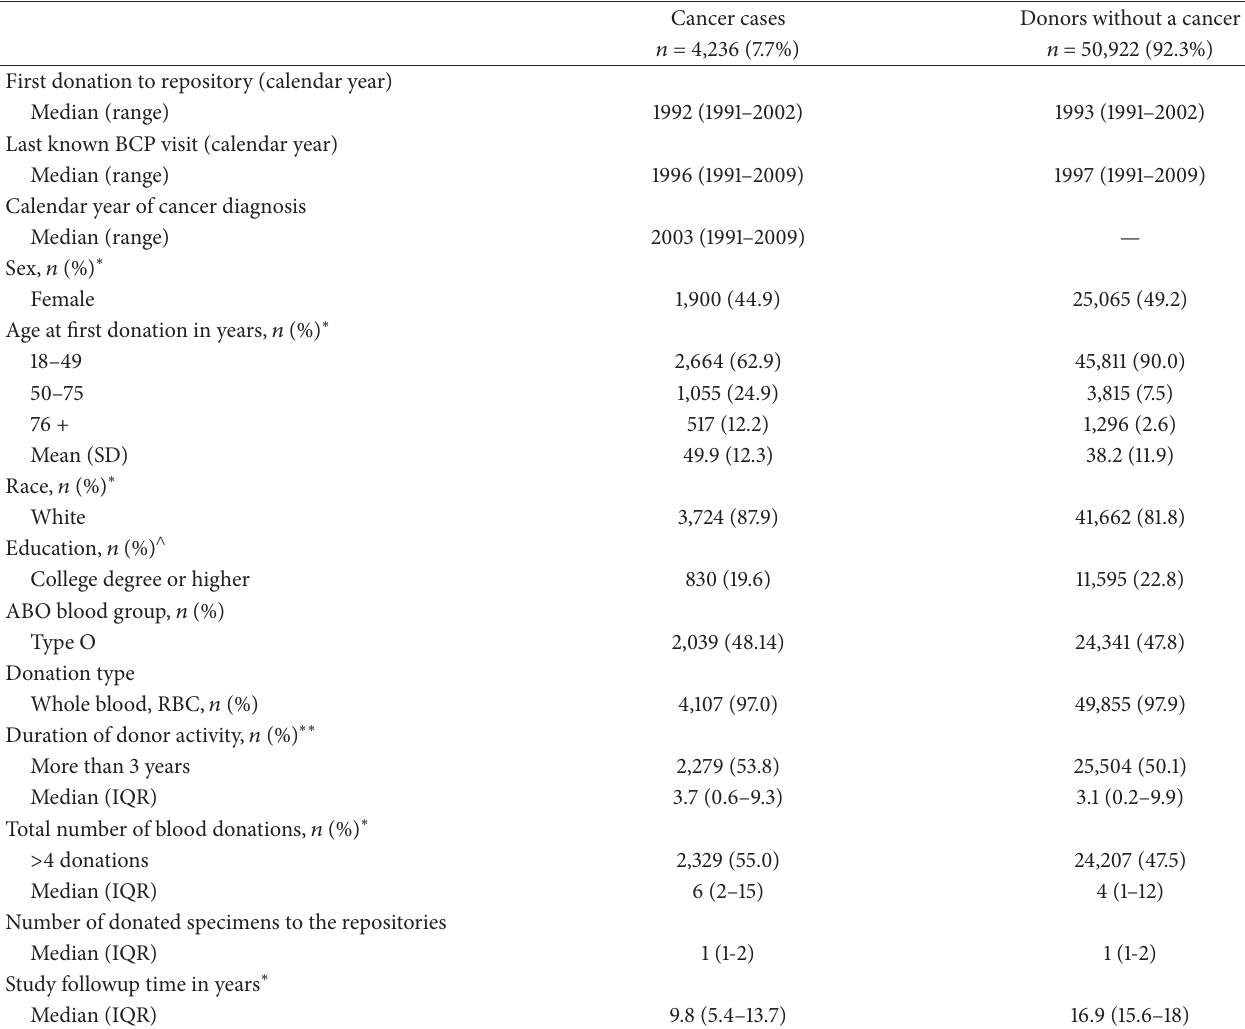
Table 1: Characteristics of allogeneic donor study population with specimens in REDS repositories by cancer status—Blood Centers of the Pacific, 1991–2009 ( 𝑛 =